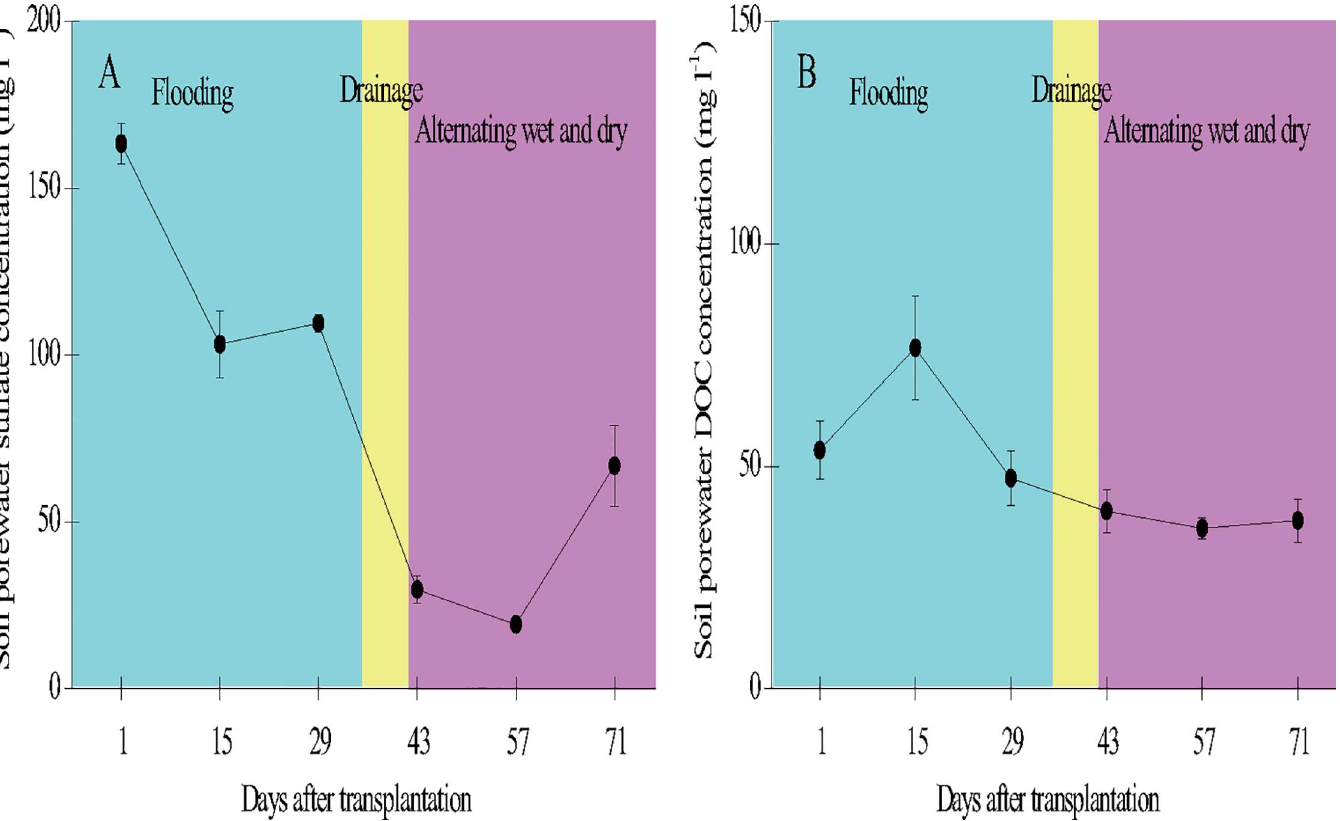
Fig 6. Temporal variation of soil porewater sulfate (A) and dissolved organic carbon (B) concentrations in the paddy field. Error bars indicate the standarderror of the mean of triplicate